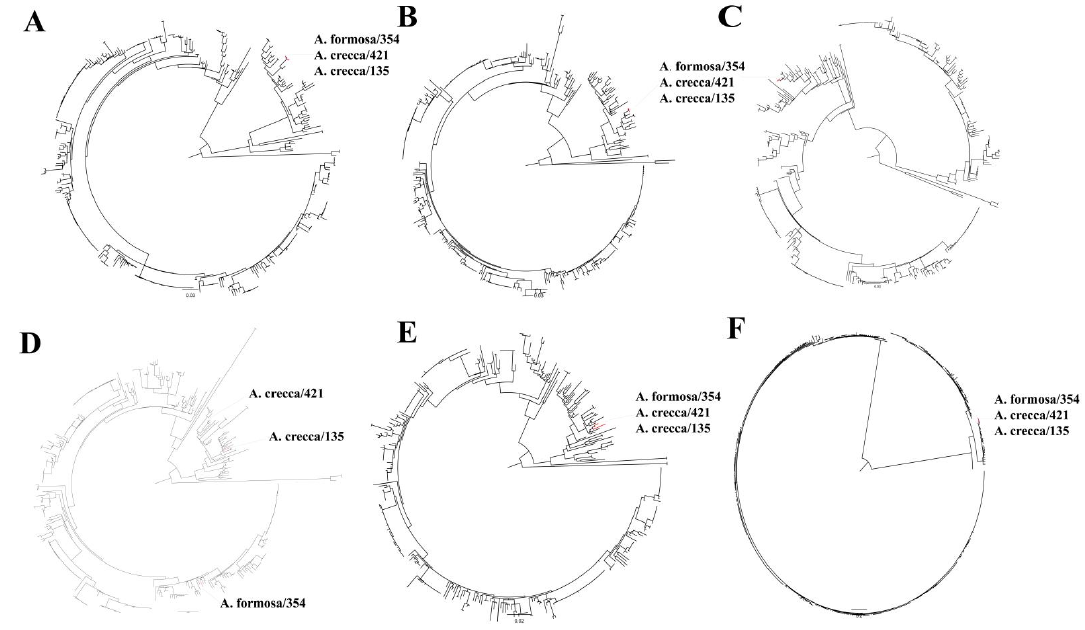
Figure 3. Phylogenetic analysis of internal genes of H12 IAVs. ( A ) PB2 genes, ( B ) PB1 genes, ( C ) PA genes, ( D ) NP genes, ( E ) M genes, and ( F ) NS genes of the three H12 viruses detected in wild birds in this study and obtained from GISAID and NCBI were analyzed. The three H12 isolates are marked in red. The ML tree was constructed by RAxML-NG. The reliability of the phylogenetic tree was estimated with 1000 bootstraps.